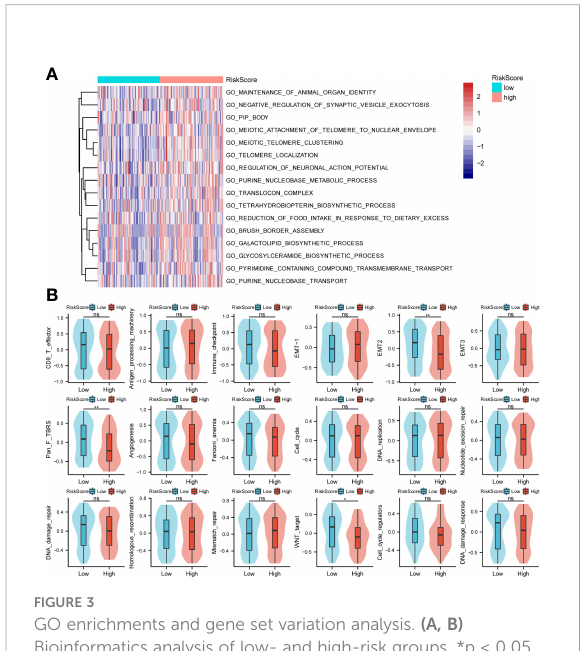
FIGURE 3 GO enrichments and gene set variation analysis. (A, B) Bioinformatics analysis of low- and high-risk groups. *p < 0.05, **p < 0.01, ns, not signi fi